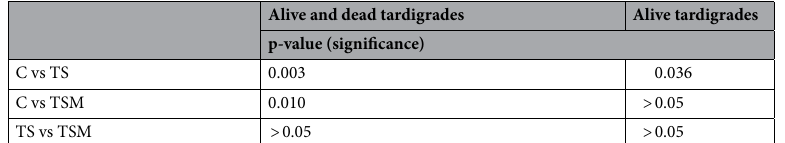
Alive and dead tardigrades Alive tardigrades p-value